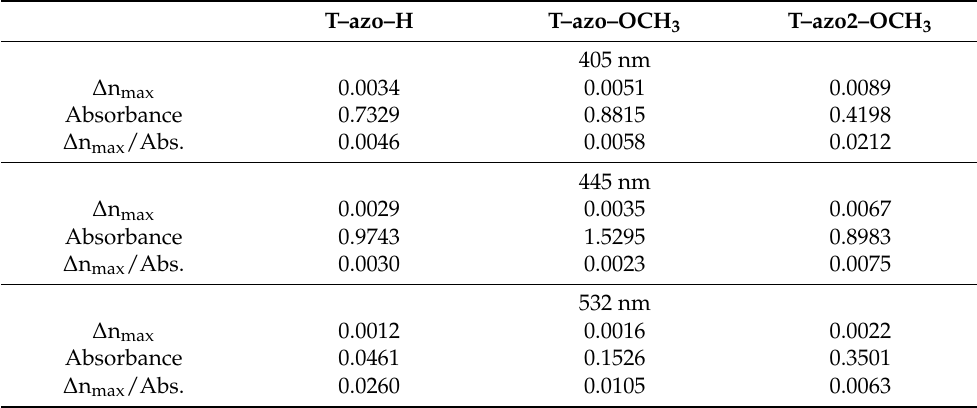
Table 3. Maximum birefringence values, absorbance at the excitation wavelengths and their ratio for T–azo–H, T–azo–OCH 3 and T–azo2–OCH 3